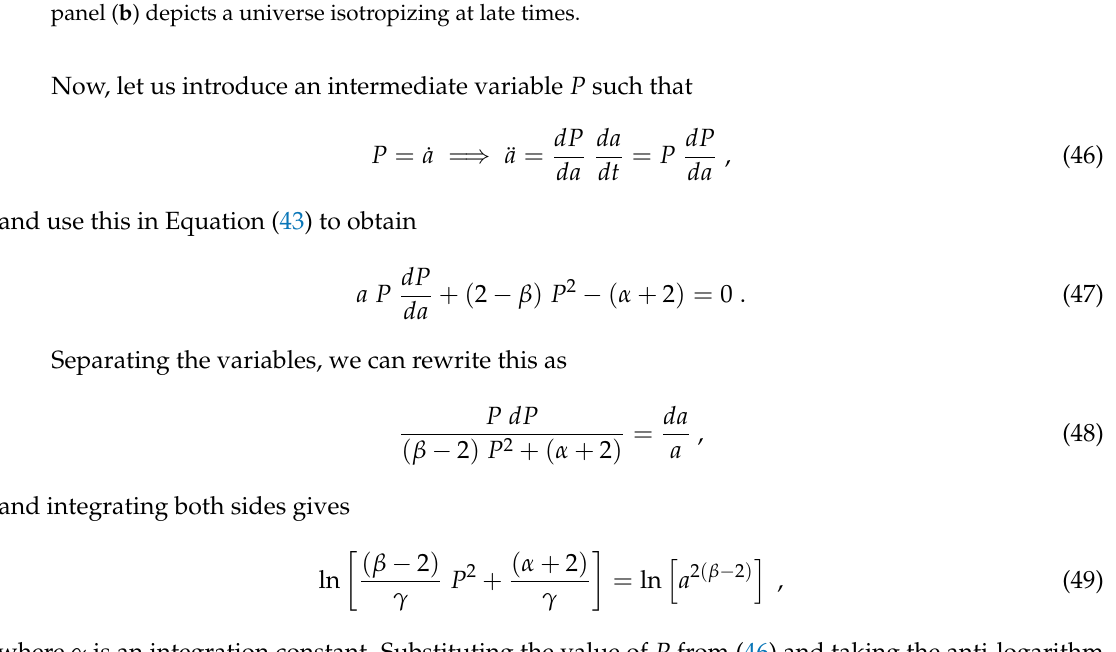
Figure 5. The variation of V and σ for α = − 2 , β = 1 . The panel ( a ) depicts a monotonically increasing volume of the the universe (as would be expected due to the cosmological expansion) whereas the panel ( b ) depicts a universe isotropizing at late